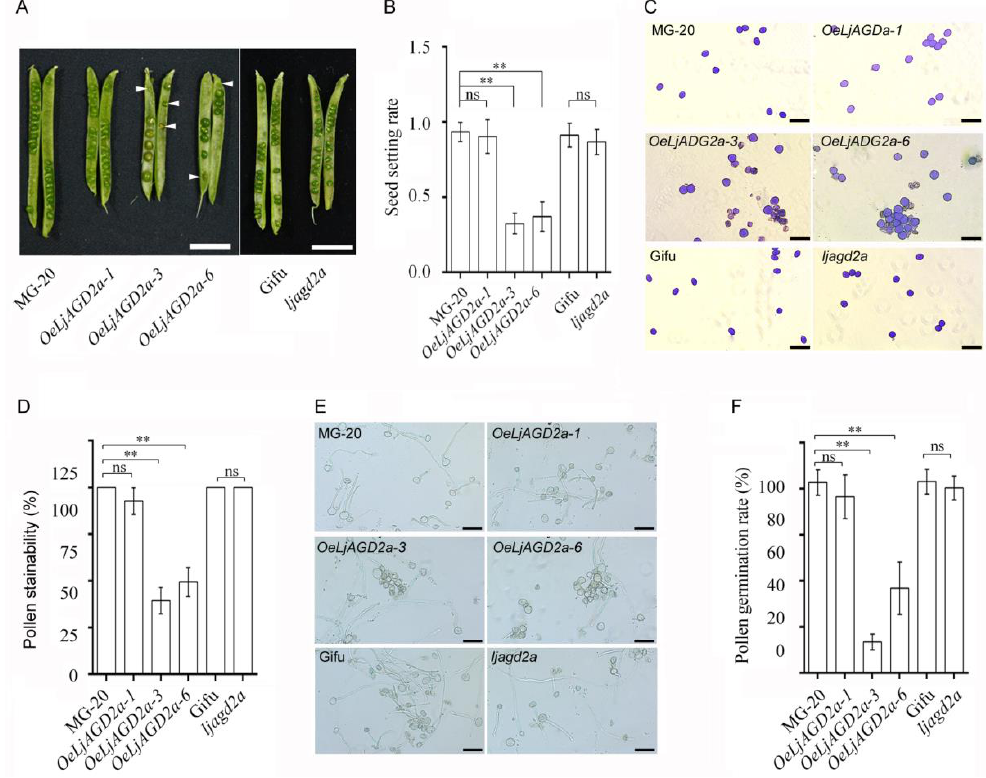
Figure 5. Effects of changing expression of LjAGD2a on fertility in L. japonicus . ( A ) Immature seeds in OeLjAGD2a siliques. Aborted dead seeds are indicated by arrows. Scale bar = 1 cm. ( B ) Measured seed setting rates, which were dramatically decreased in OeLjAGD2a plants, relative to wildtype rates, but not significantly altered in ljagd2a mutants (means obtained from analyses of more than 50 siliques with standard deviations: ** indicate p < 0.01, respectively, according to the Duncan test). ( C ) Photograph showing morphology of pollen grains. ( D ) Stainability of pollen by iodine-potas- sium iodide solution, indicating viability. ( E ) Photograph showing results of in vitro pollen germi- nation assays. ( F ) Pollen germination rates, based on analyses of pollen grains from 5 to 7 anthers of each of 8 to 10 plants (** and ns indicate p < 0.01 and no significant difference, respectively, according to the Duncan test). Scale bar = 50 µm in ( C , D ). Error bars in ( B , D , F ) indicate the SD of three biolog- ical replicates.